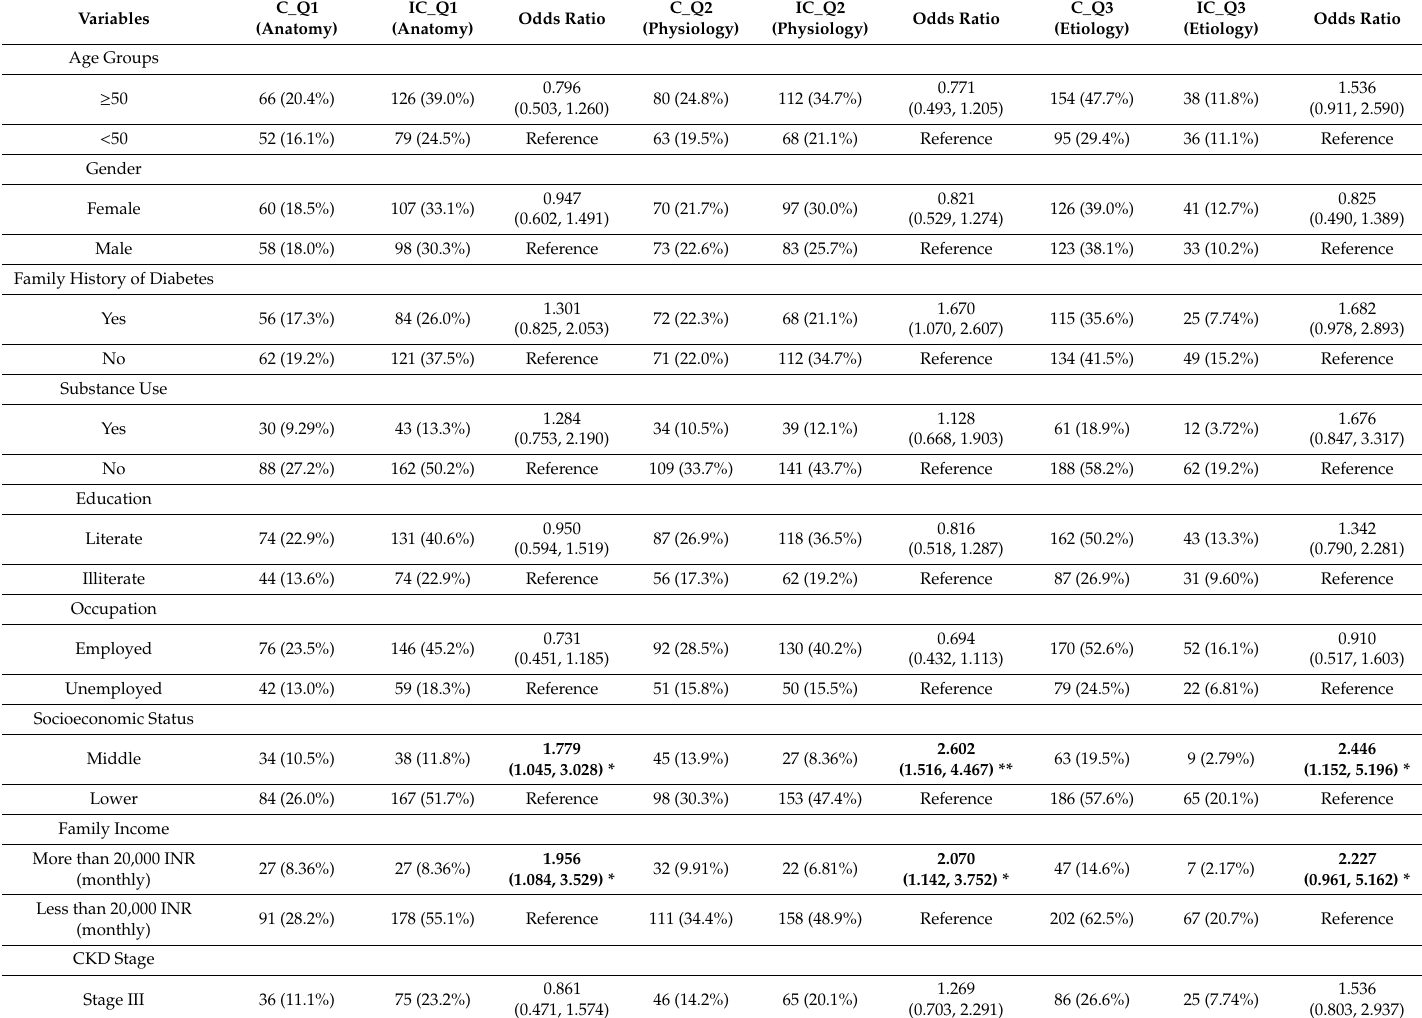
Table 3. Association between di ff erent domains of knowledge and demographic